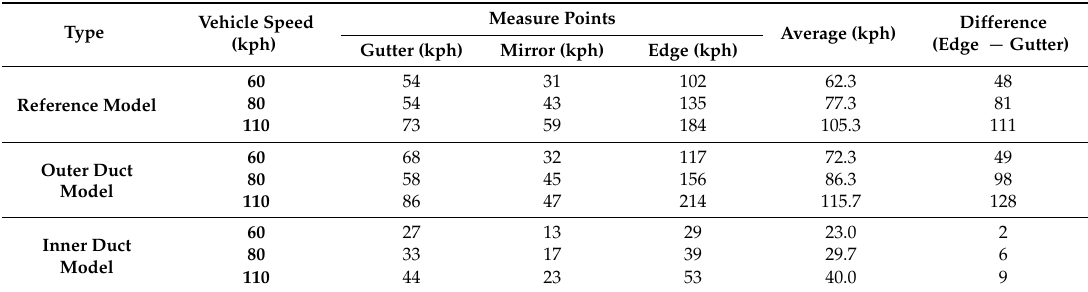
Table 2. Simulation results of velocities according to vehicle driving speed at the gutter, the mirror surface, and the edge of the three OSRVM